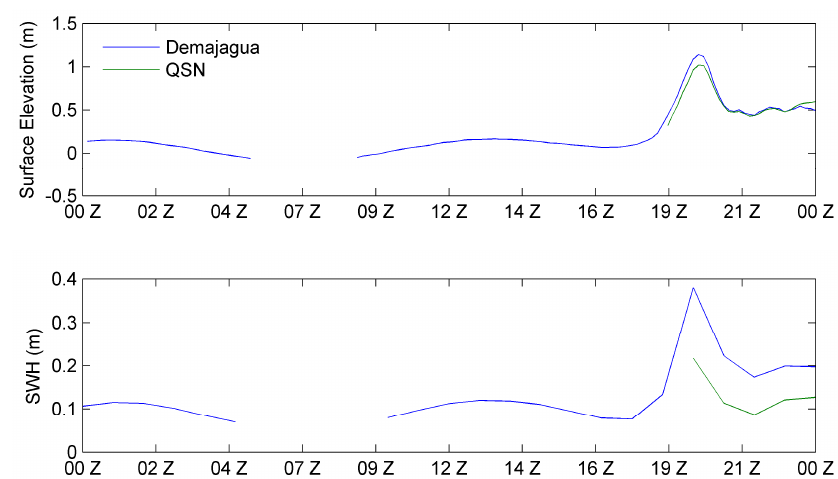
Figure 17. ADCIRC + SWAN water surface levels at Demajagua (blue) and QSN 1959 (green) outlets during Hurricane Georges ( Top ). Notice how the tide penetrates into Demajagua while not into QSN 1959. ADCIRC + SWAN significant wave heights (SWH) at Demajagua and QSN 1959 outlets ( Bottom ). Notice how the waves reach into QSN 1959 later than the water levels, showing the fine detail achieved by the model. The plotted period is from 21 September 1998 0:00 UTC to 22 September 1998 0:00 UTC.